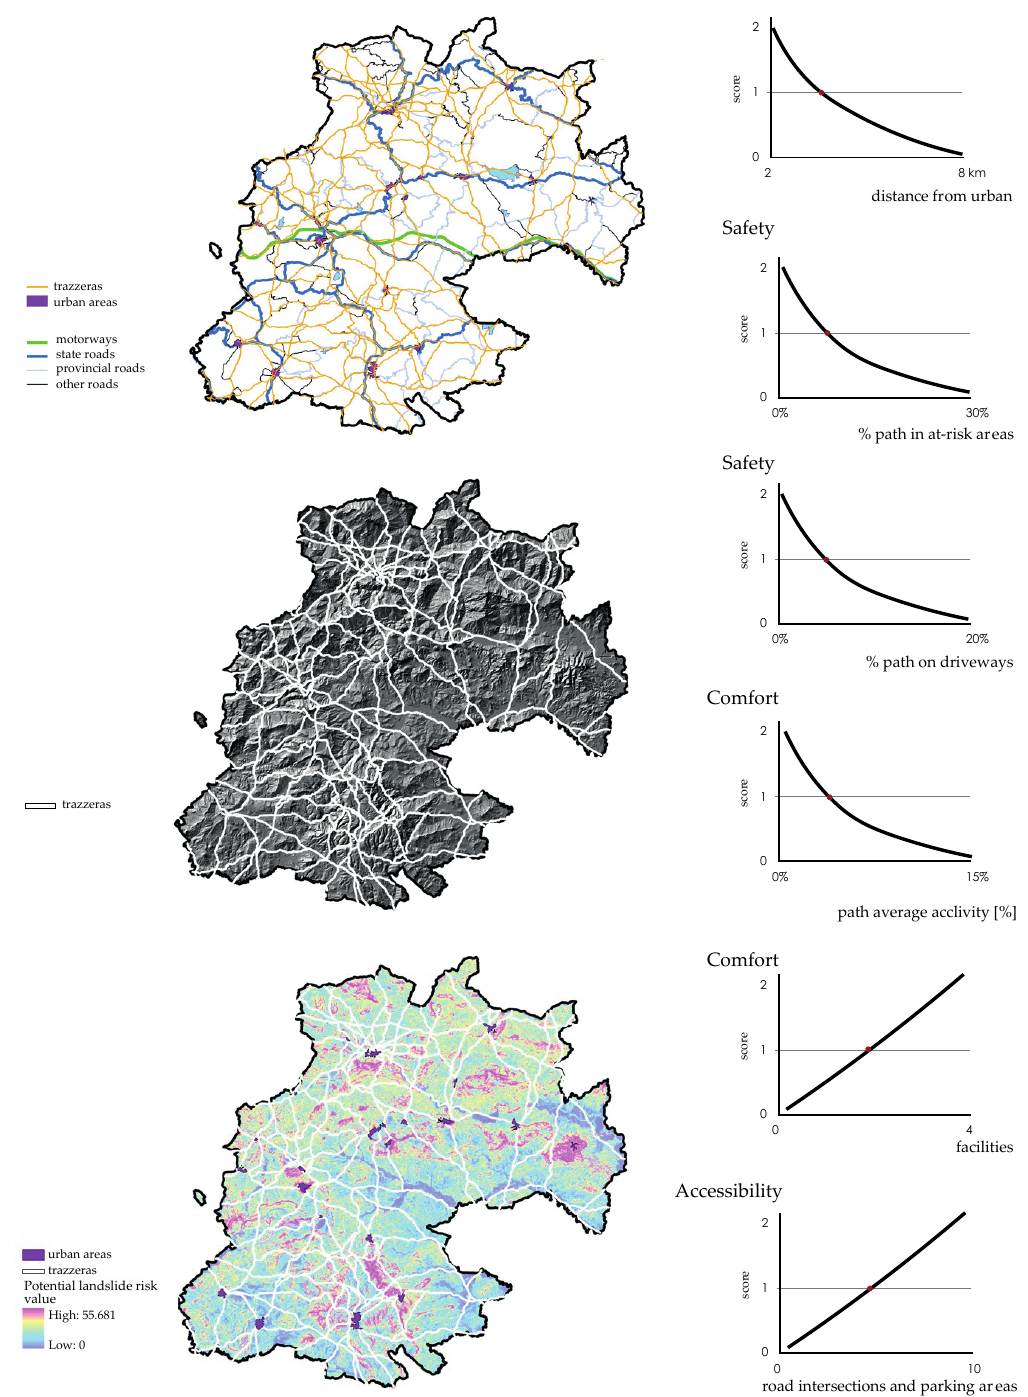
Figure 10. Practical values. Mapping and value functions.